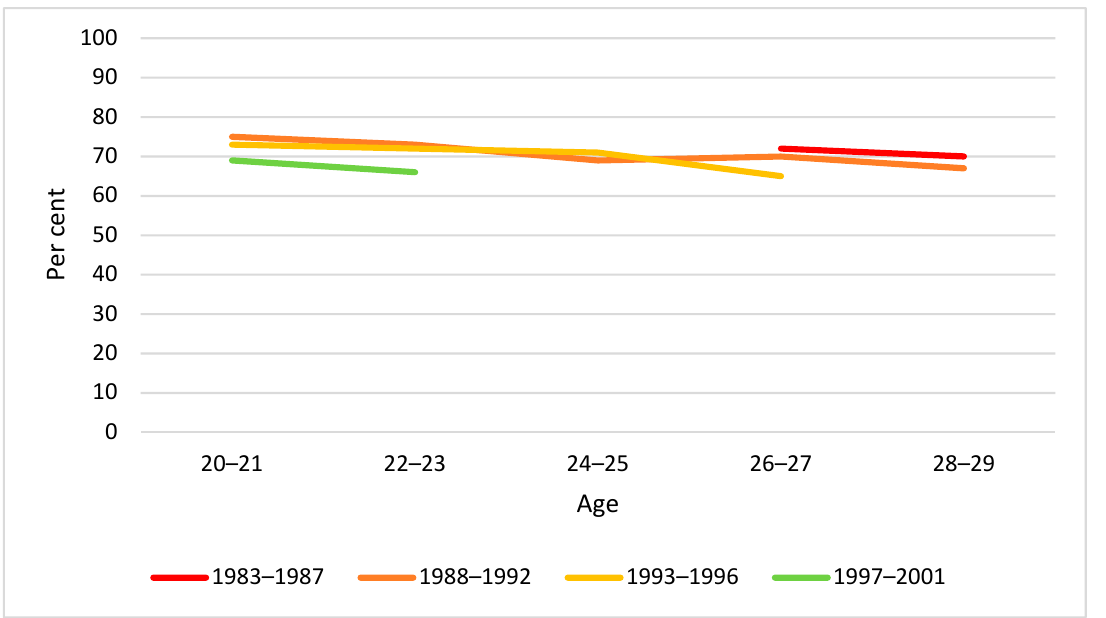
Figure 2. Proportion past year drinkers by birth cohort and age. Note: None of the cohort differences at any age were statistically significant ( p > 0.05).